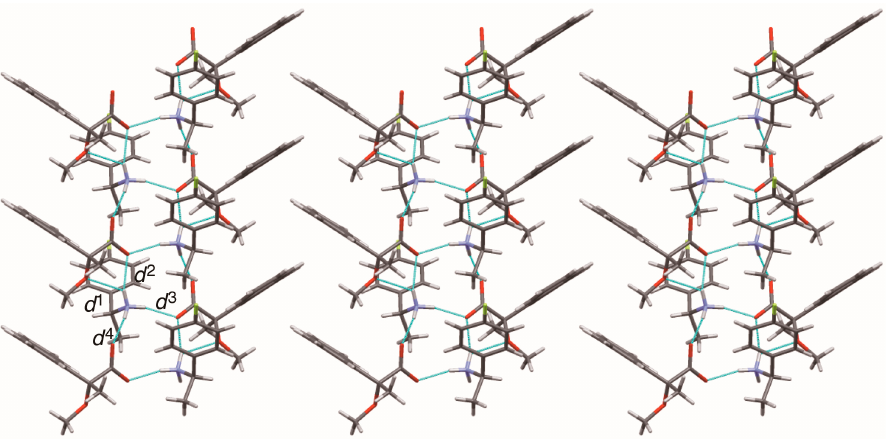
Figure 9. Sheet structure in crystalline salt 7 , consisting of 2 1 columns. The pale-blue lines show salt bridges and hydrogen bonds. See Table 3 for the interatomic distances d 1 – d 4 .